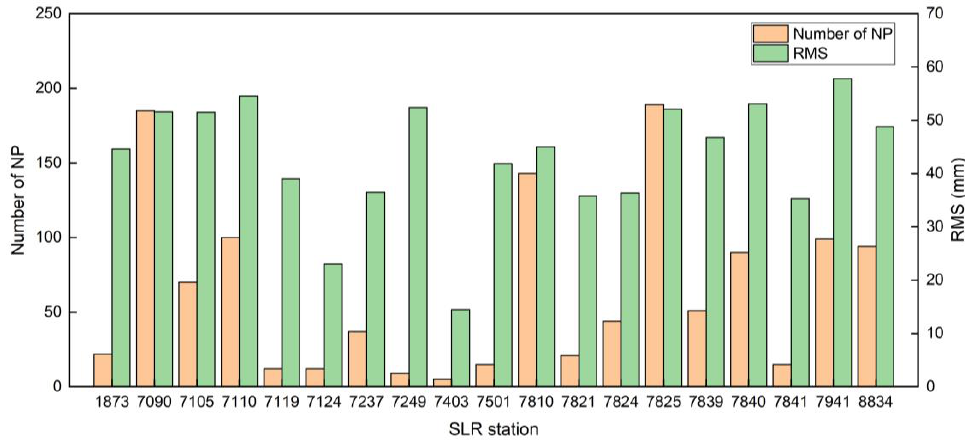
Figure 3. The amount of NP data and the RMS value of the SLR station.